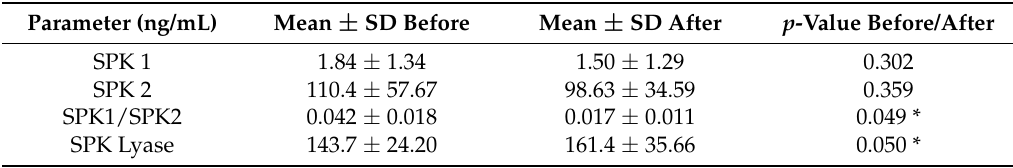
Table 3. Mean values of sphingosine phosphokinase 1 and 2 (SphK1 and SphK2) and their ratios, as well as sphingosine phosphate lyase (SPL), before and after treatment.